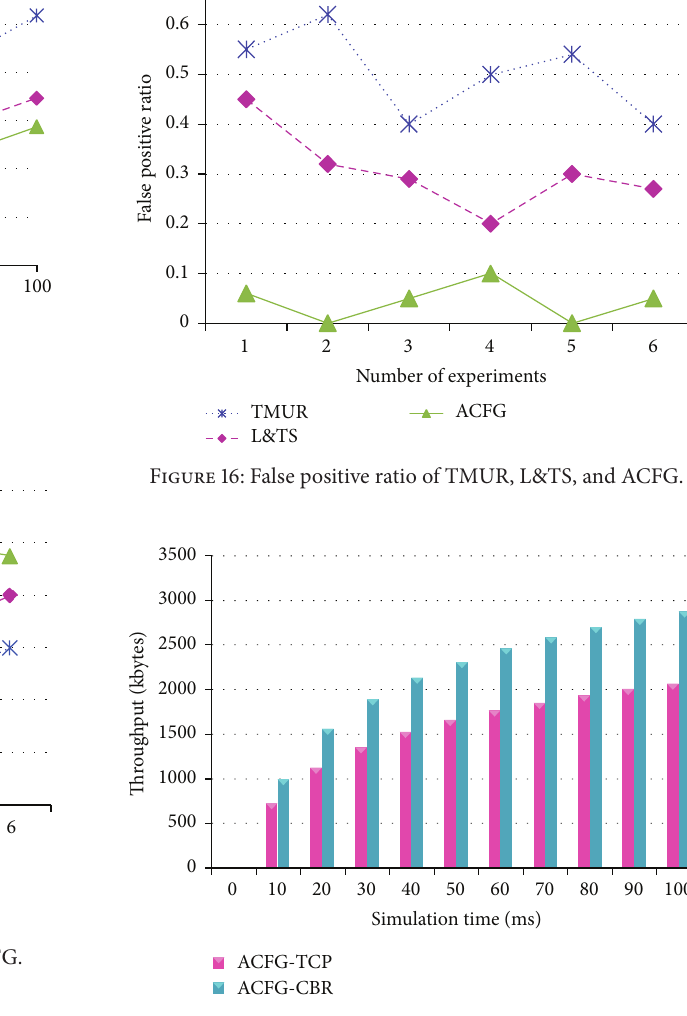
Figure 17: Throughput of ACFG with CBR and TCP